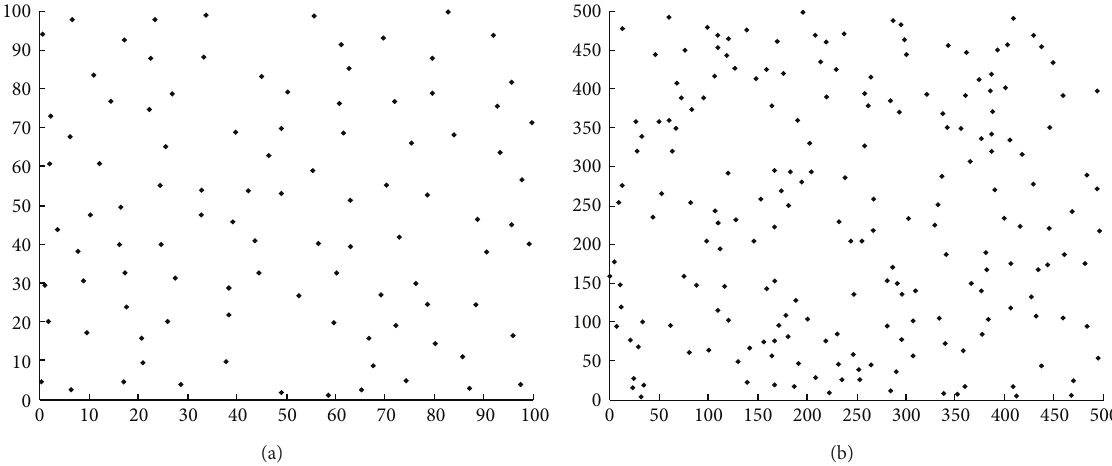
Figure 2: (a) Unclustered 100 sensor nodes in 100m × 100 m WSN. (b) Unclustered 200 sensor nodes in 500 m × 500m